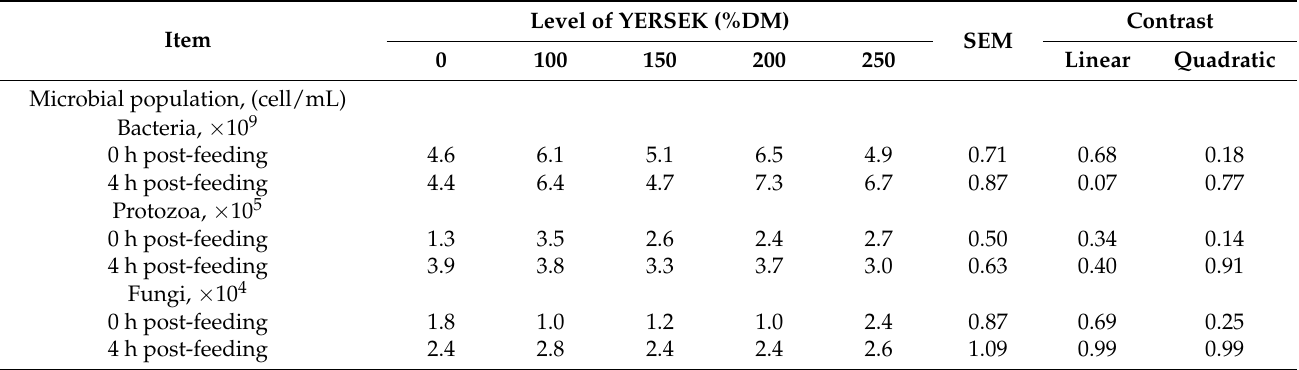
Table 5. Effect of YERSEK on microbial population in dairy